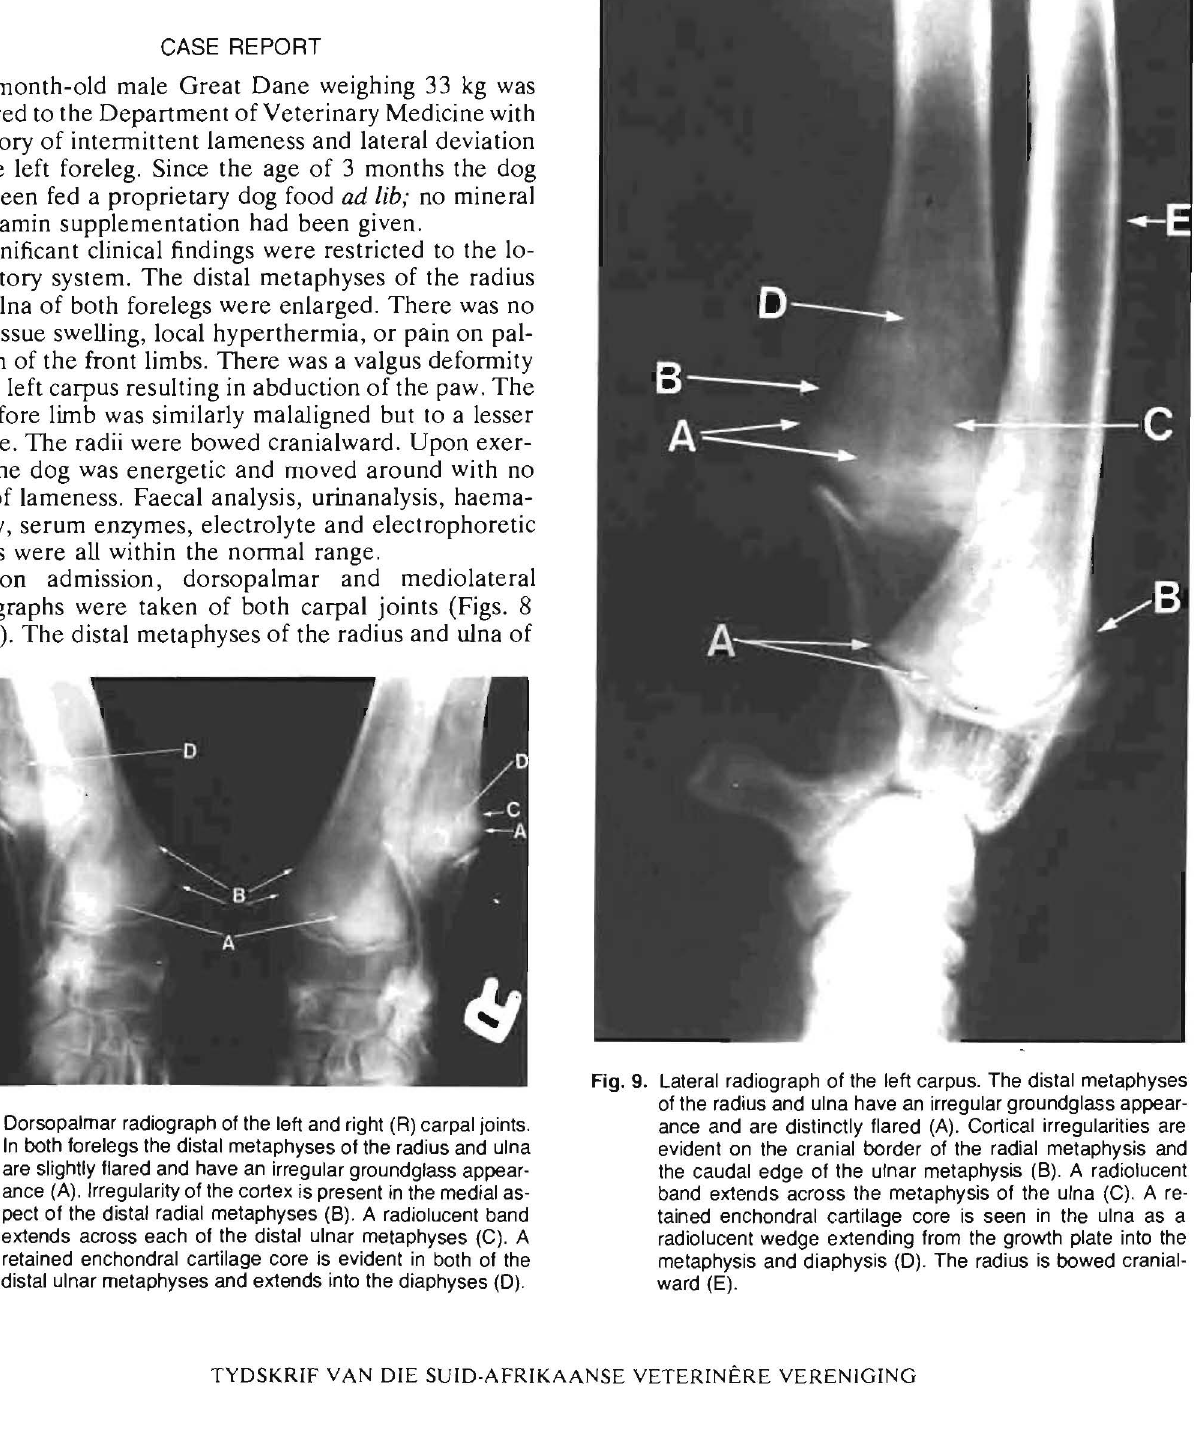
TYDSKRIF VAN DIE SUID·AFRIKAANSE VETERINERE